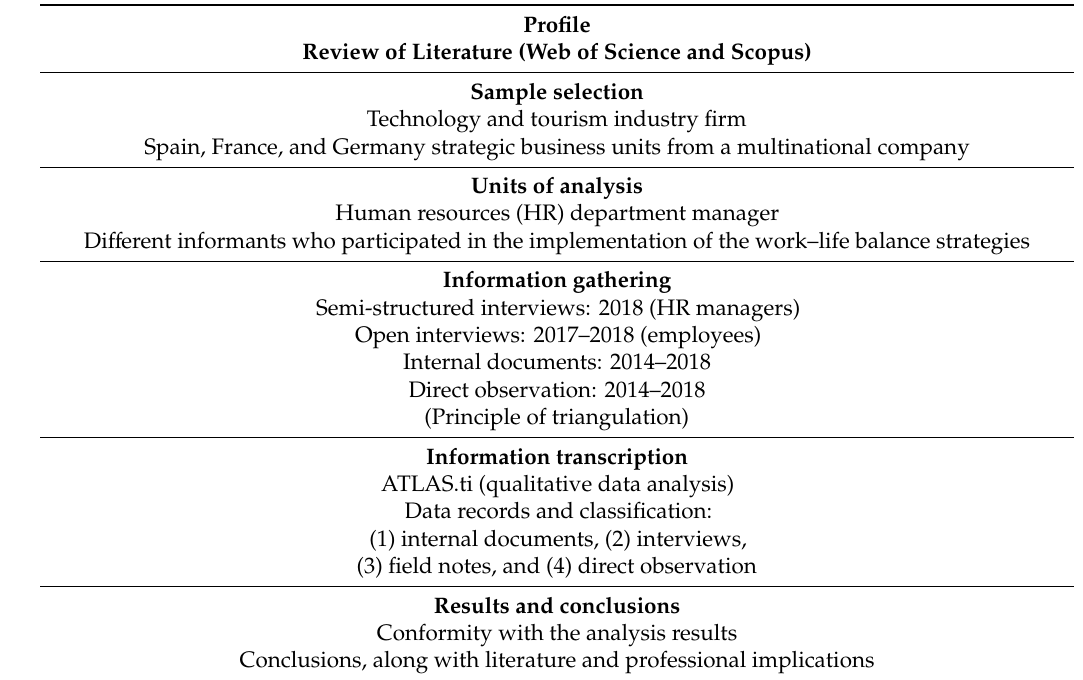
Table 1. Stages of the case